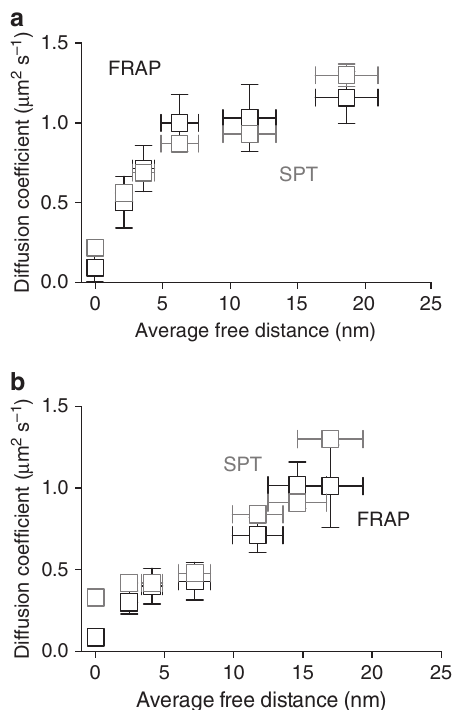
Figure 5 | Comparison of VSG diffusion analysed by SPT or FRAP measurements. The impact of the lateral protein density in supported membranes on the diffusion of wild type ( a ) or N-glycosylation deficient VSG121 ( b ) was analysed using SPT (grey squares) and FRAP (black squares). The error bars in y (diffusion coefficient) represent the standard deviation of the mean, while the error bars in x (average free distance) depict the range. SPT, single-particle